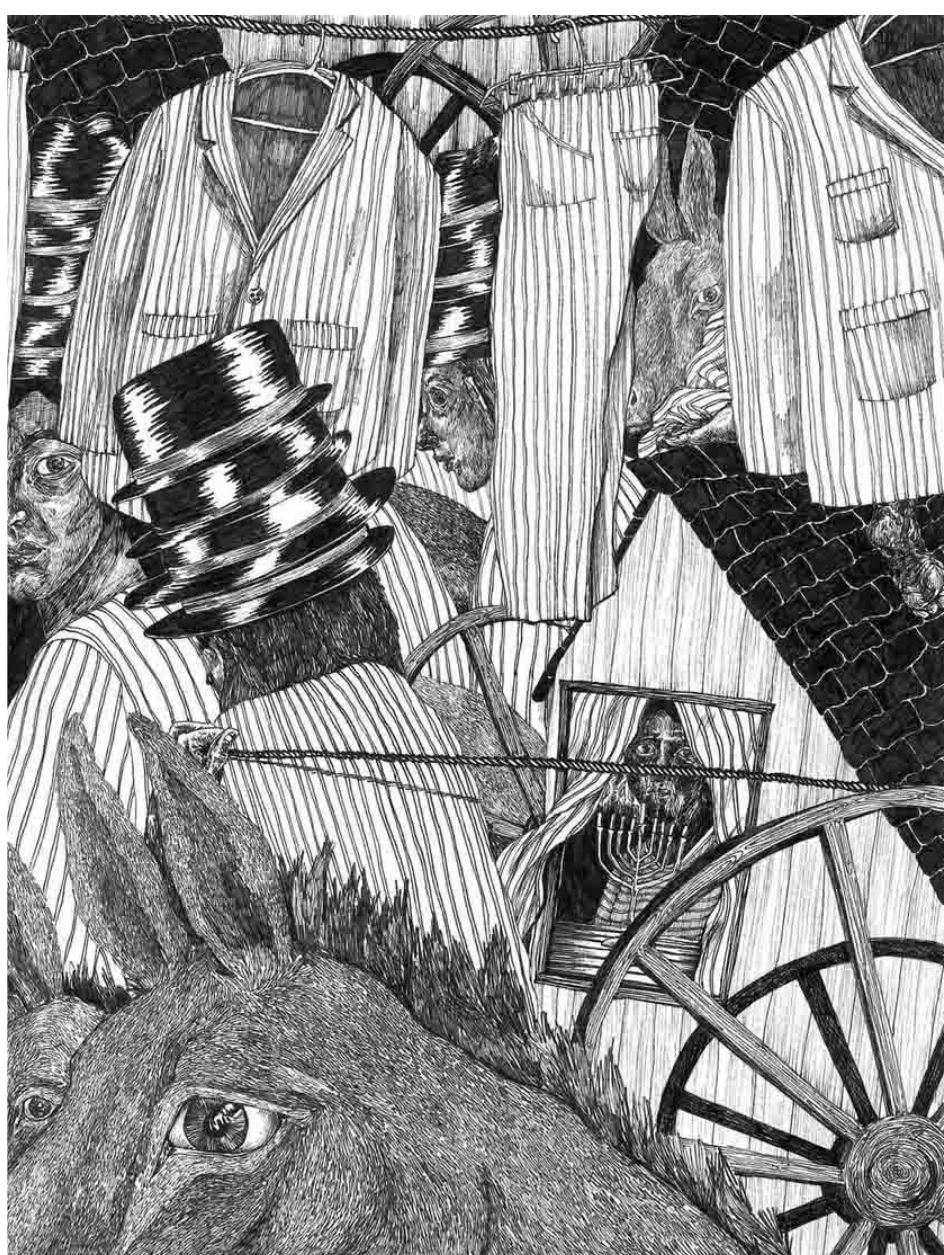
Rosabel Rosalind Kurth-Sofer, Exodus VII , 2018. Pen and ink on paper. 9x11